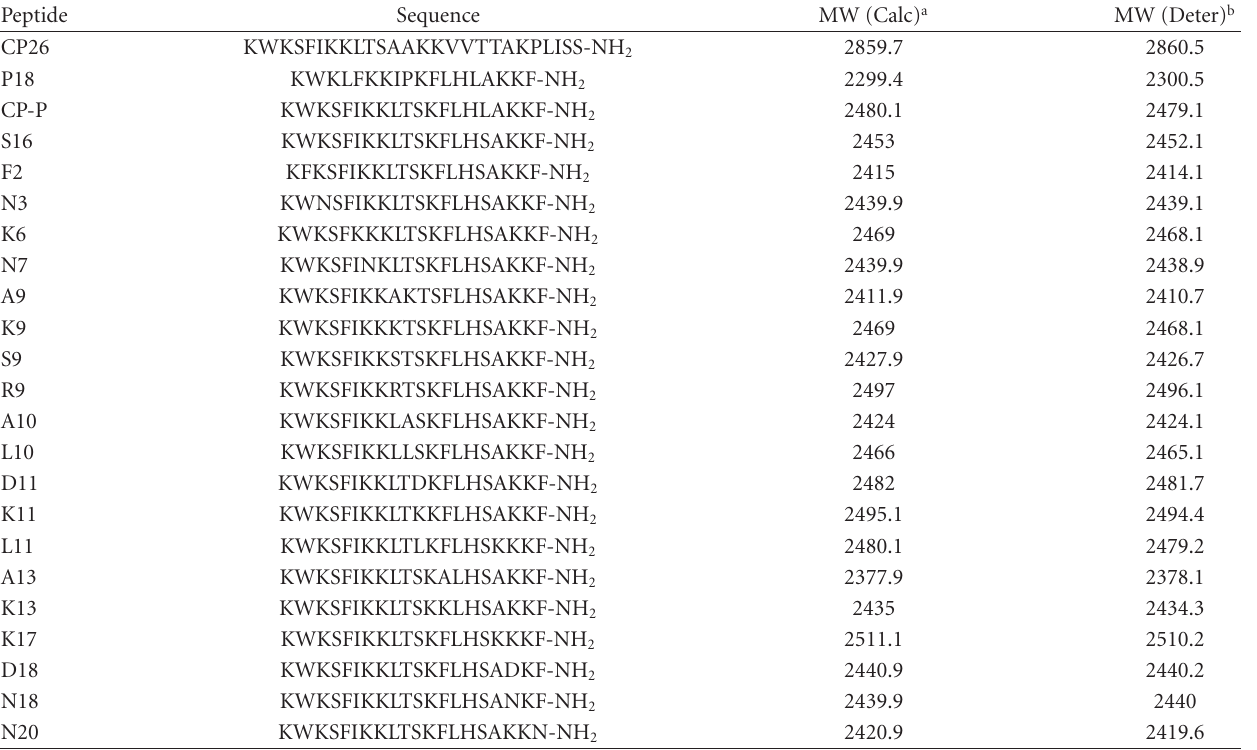
Table 1: Peptide sequences.